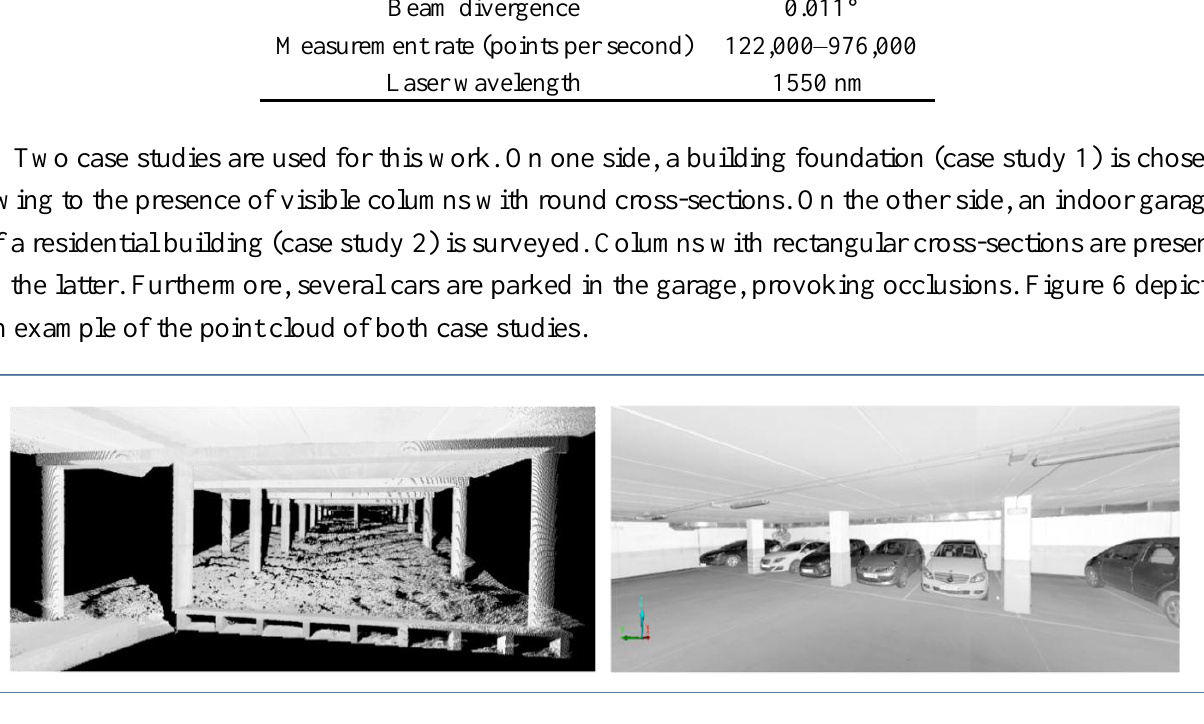
Figure 6. Example of the point cloud from the building foundation ( left ) and the indoor garage of a residential building ( right